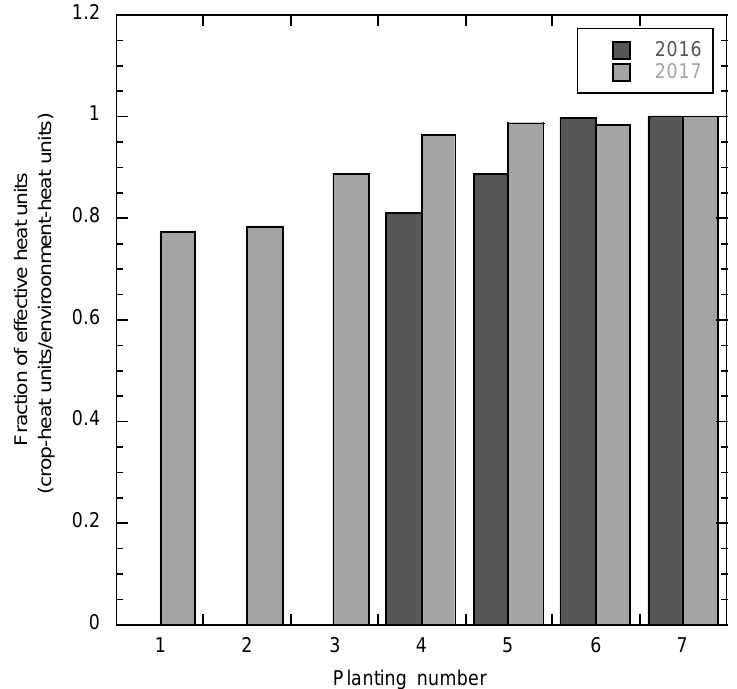
Figure 13. The difference between the environment-heat units and crop-heat units for four plantings in 2016 and seven plantings in 2017. Plantings 1 through 3 in 2016 were lost to a hailstorm and never reached maturity date.